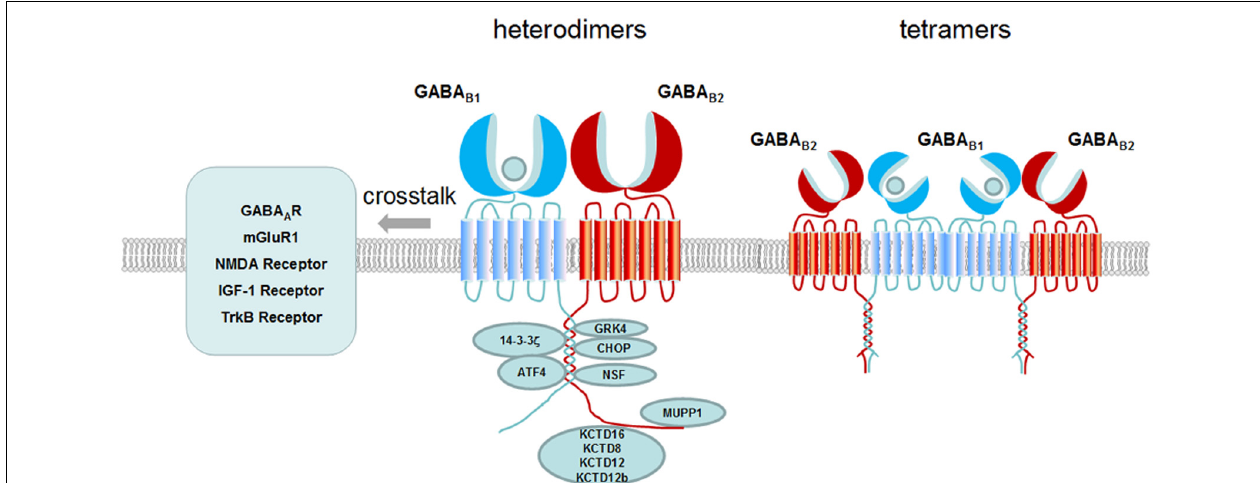
FIGURE 2 | Schematic presentation of GABA B receptor interacting proteins and crosstalk of GABA B receptor with other receptors. GABA B receptor interacting proteins are binding to the C-terminus of GABA B receptor modulating the receptor membrane expression (e.g., CHOP, MUPP1), desensitization (e.g., GRK4, NSF), signaling transduction (e.g., G proteins, ATF4) and diverse function (e.g., 14-3-3 ζ , KCTD8,